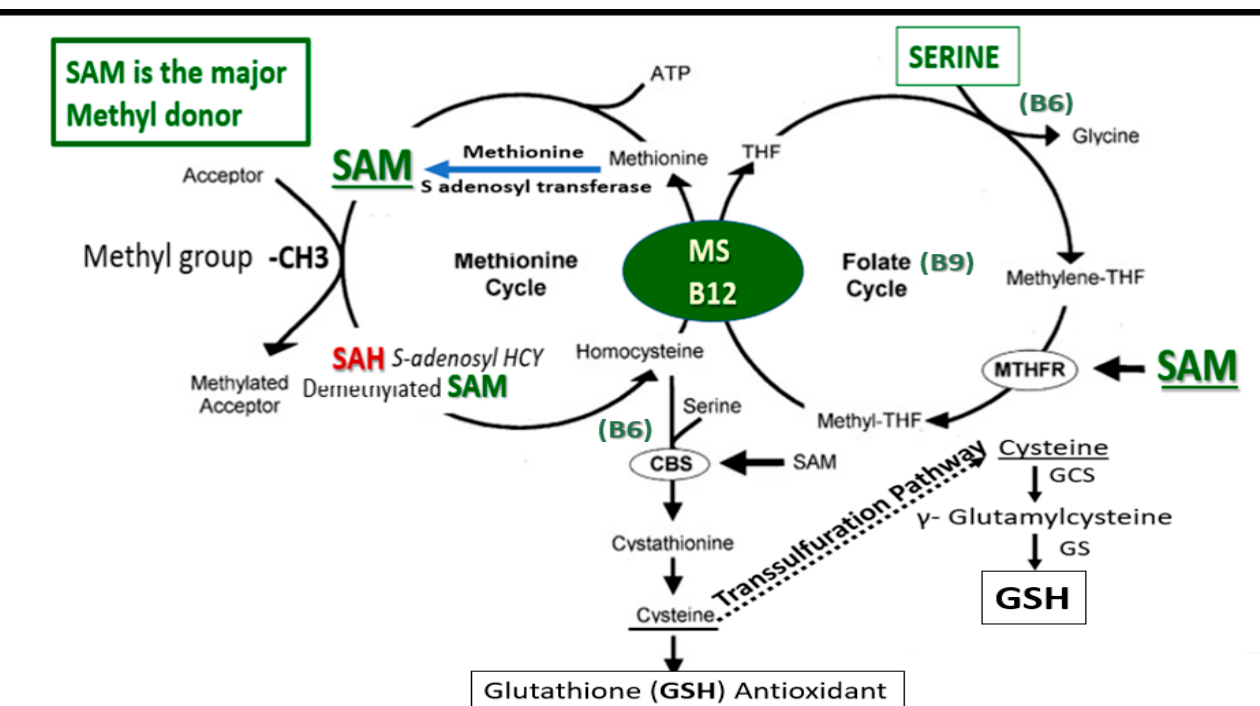
Figure 1. Folate-Mediated One-Carbon Metabolism (FOCM). This figure illustrates both the folate and methionine interdependent cycles and supports the importance of the methyl donor S-adenosylmethionine (SAM) as well as demonstrating the importance of the essential B vitamins. Importantly, note that methionine and tetrahydrofolate (THF) are derived primarily through dietary intake to supply the methionine and folate cycles and that the enzyme methionine synthase (MS) and its essential cofactor vitamin B12 are placed in a central position of the interconnected folate and methionine cycles. FOCM comprises a network of interconnected folate-dependent metabolic pathways responsible for serine and glycine interconversion, de novo purine synthesis, de novo thymidylate synthesis and homocysteine remethylation to methionine as well as providing antiox- idant defense via glutathione (GSH) production via the transsulfuration pathway. Note that the encircled methylenetetrahydrofolate reductase (MTHFR) enzyme plays and important role in the folate cycle. The most common genetic variant in MTHFR gene to date is the 677C > T polymor- phism, which results in elevated levels of Hcy especially if there is deficient folate. Once Hcy is synthesized through multiple steps in the methionine cycle, it may then undergo remethylation to methionine or be eliminated through the transsulfuration pathway. Additionally, thymidylate synthase (TYMS) converts deoxyuridine monophosphate (dUMP) to deoxythymidine monophos- phate (dTMP) (not shown) in a 5,10-methylene-THF-dependent reaction. Importantly, cystathionine beta synthase (CBS) and cystathionine gamma lyase (CSE-CGL) do not only contribute to gener- ate GSH (antioxidant) in the transsulfuration pathway but also are important for endothelial cell generation of hydrogen sulfide (H 2 S), a known gaso-transmitter and vasodilator. Elevation of Hcy from the methionine cycle may result in hyperhomocysteinemia, which is an independent risk factor for cerebro - cardiovascular diseases, accelerated atherosclerosis, thromboembolism, hypoxemia and stroke. CBS = cystathionine-beta-synthase; GCS = glutamate cysteine ligase (gamma-glutamylcysteine synthetase); GS = glutathione synthase; GSH = glutathione; MTHFR = methylenetetrahydrofolate; MS = me- thionine synthase; THF = tetrahydrofolate